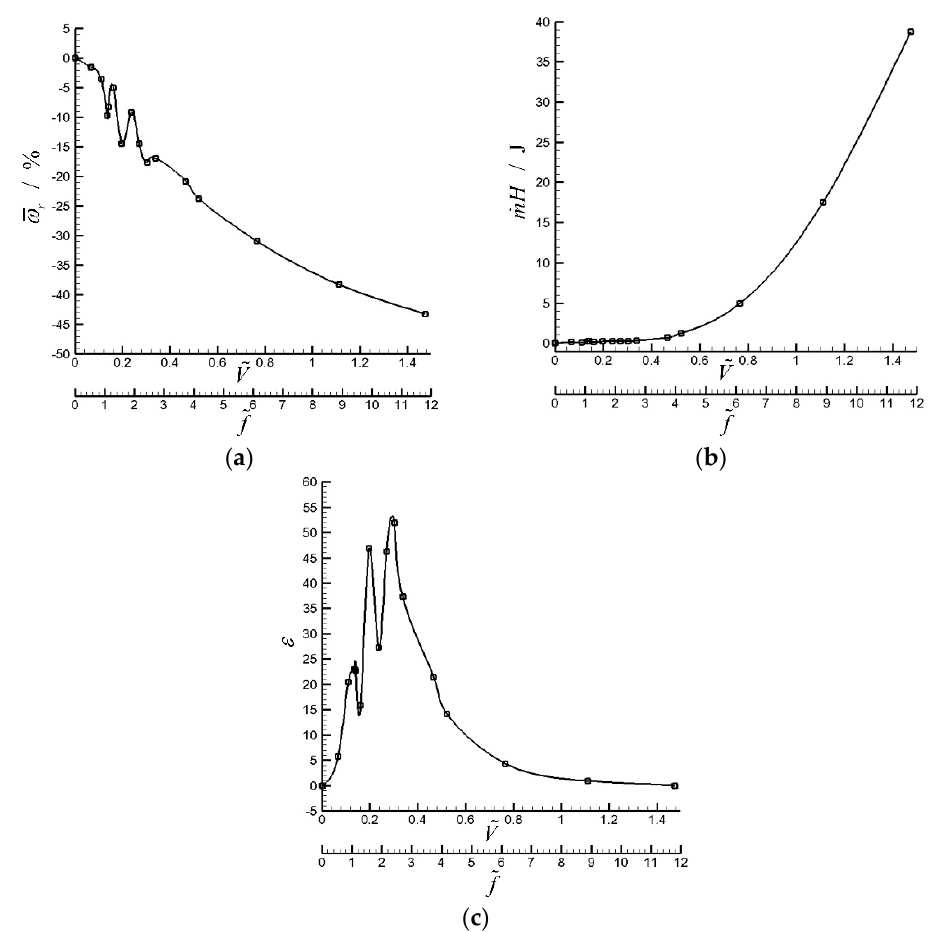
ω versus dimensionless phase r . mH versus dimensionless